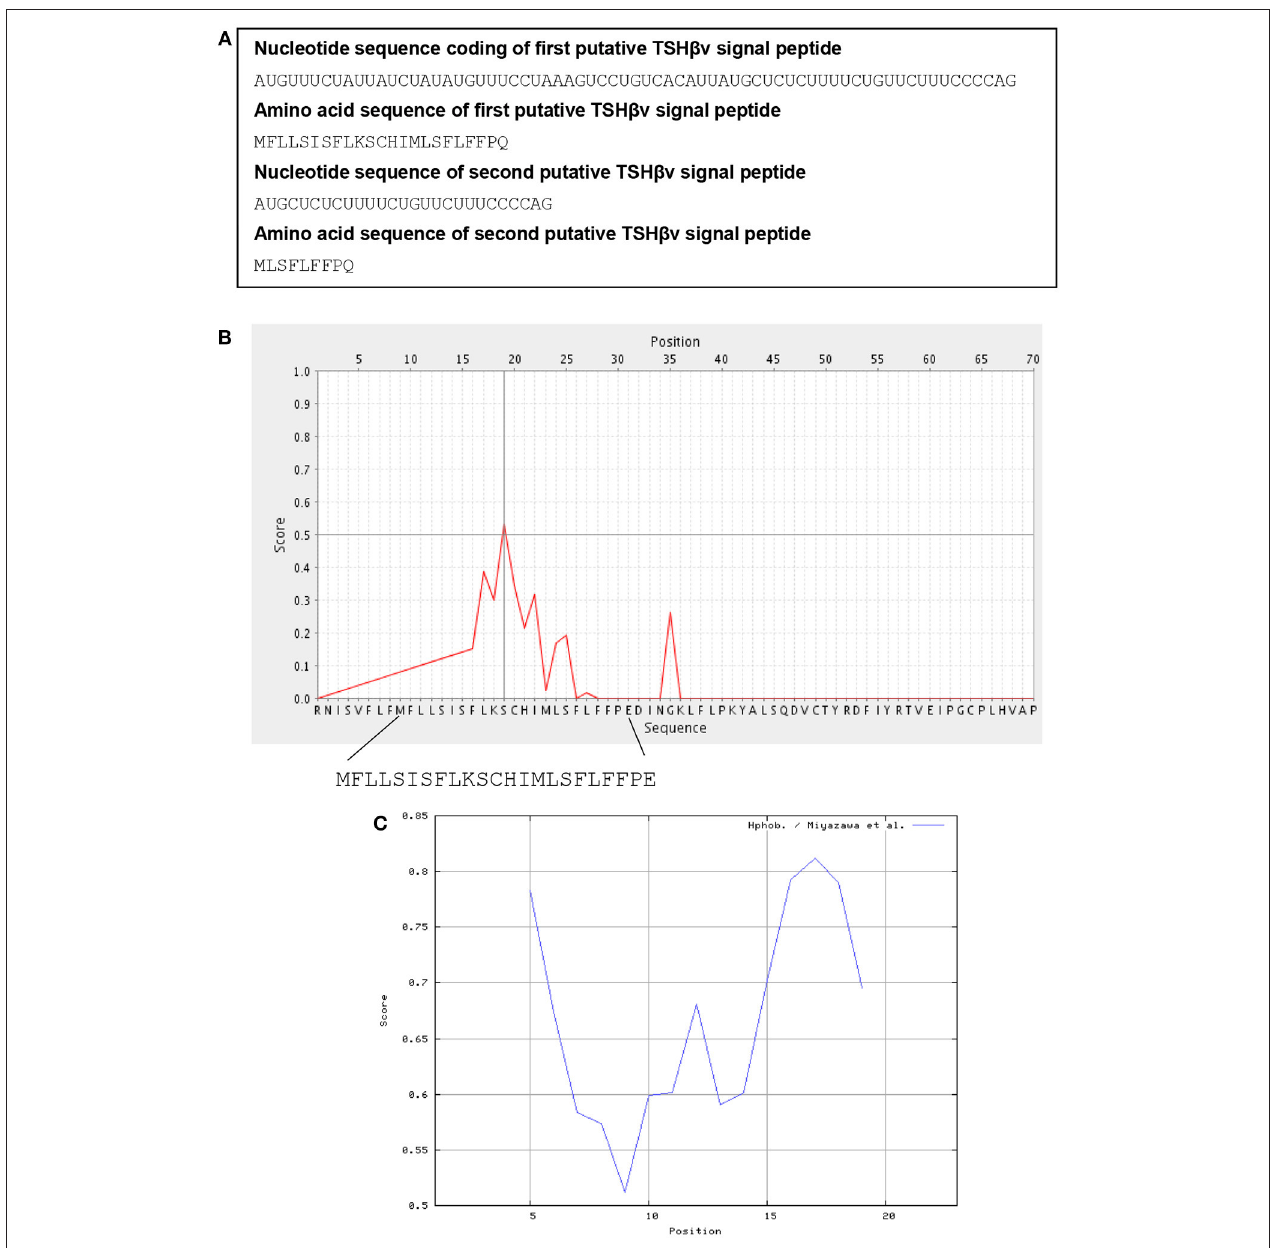
FIGURE 2 | Signal peptide analysis of TSH β v in intron 2. (A) The nucleotide and amino acid sequences at the 3 ′ end of intron 2 (see Figure 1C , bold sequences) that code for a putative 23 and 9 amino acid signal peptides of TSH β v. (B) Biophysical properties of the putative 23 amino acid TSH β v signal peptide as determined using a PrediSi signal prediction program, the 23 amino acid peptide with the serine reside at position 11 likely representing the cleavage site. (C) The 23 amino acid signal peptide has hydrophobicity scores between 0.5 and 0.85 in a range from 0.0 (lowest hydrophobicity) to 1.0 (highest